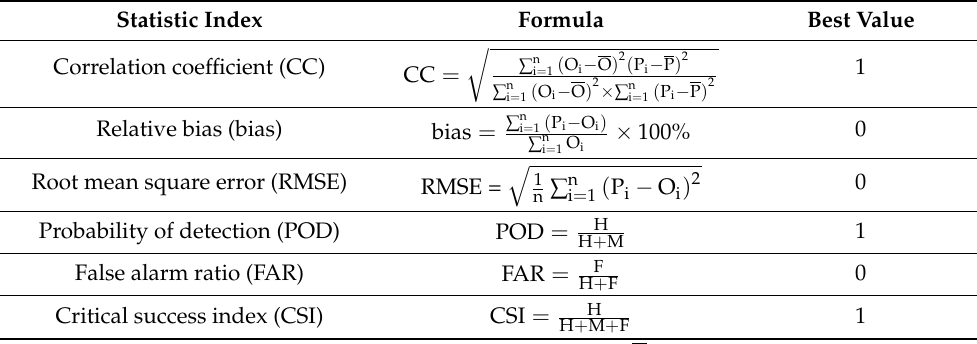
Table 2. List of the validation statistical metrics for evaluating satellite-based precipitation products in the